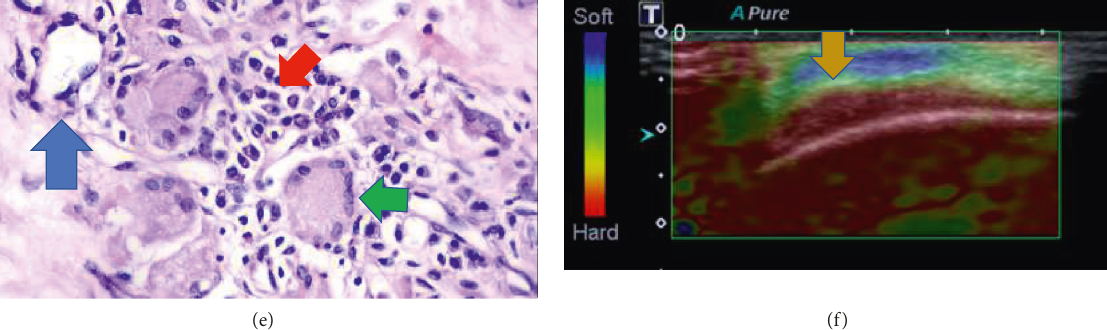
Figure 8: (a–f). A 34-year-old patient with silicone implants for 8 years. Breast ultrasonography shows thickening of the breast implant capsule, associated with pericapsular edema (yellow arrow). Figures b and c show increase in vascularity at the inflammatory site at collor (a) and spectral (b) images. Figures d and f show the hard pattern of the diseased capsule at elastography. The histology of the area shows inflammatory cells as lymphocytes (red arrow) and foamy histiocytes (green arrow) associated with silicone corpuscles (blue